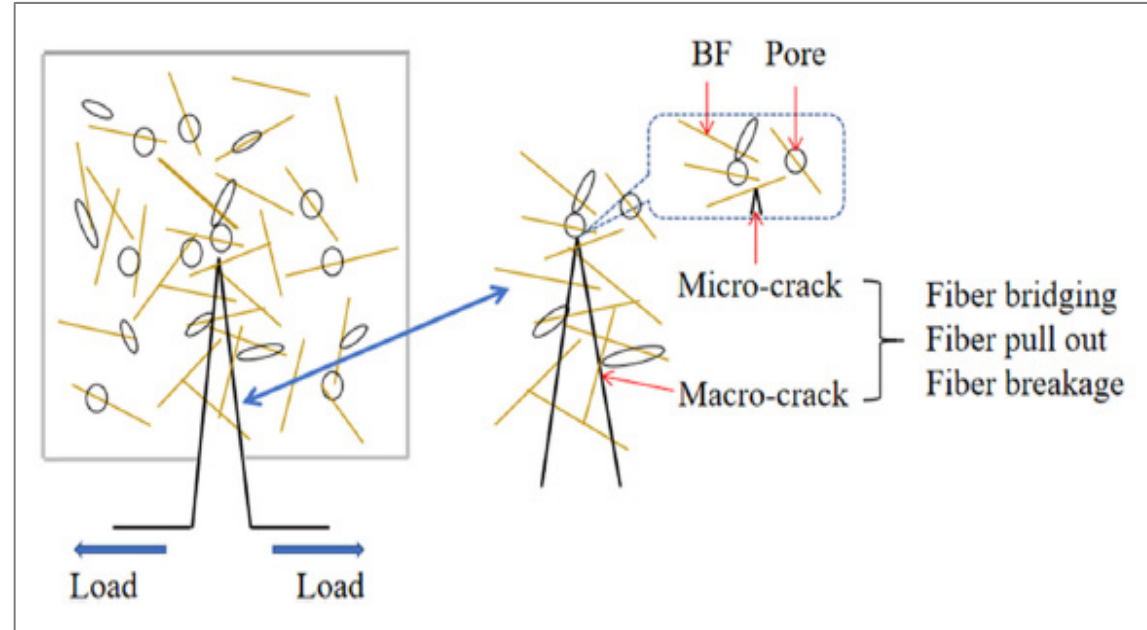
Figure 8. Multi Scale Crack Resistance [73].